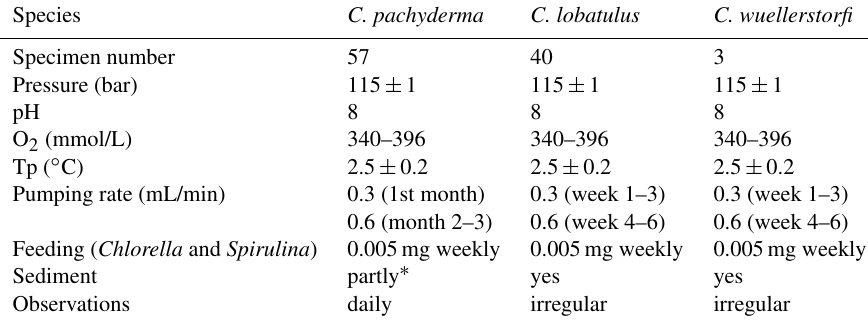
Table 1. Basic parameters of the culture experiments. Oxygen and pH values were measured with a combined O 2 and pH measuring device (WTW Multi 3620 IDS) and respective O 2 (WTW FDO ® 925) and pH (SenTix ® 980) sensors three times per week. Fine-grained siliceous oxide (1–5µm) was used as artificial sediment in one out of four aquaria in the C. pachyderma ( ∗ ) and in all aquaria of the C. lobatulus/C. wuellerstorfi culture